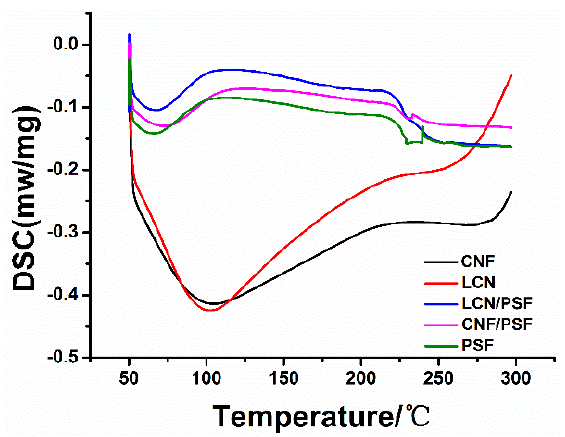
Figure 9. Differential scanning calorimetry curves of CNF, LCN, Sample M0 (PSF), Sample M4 (CNF/PSF) and Sample M10 (LCN/PSF).